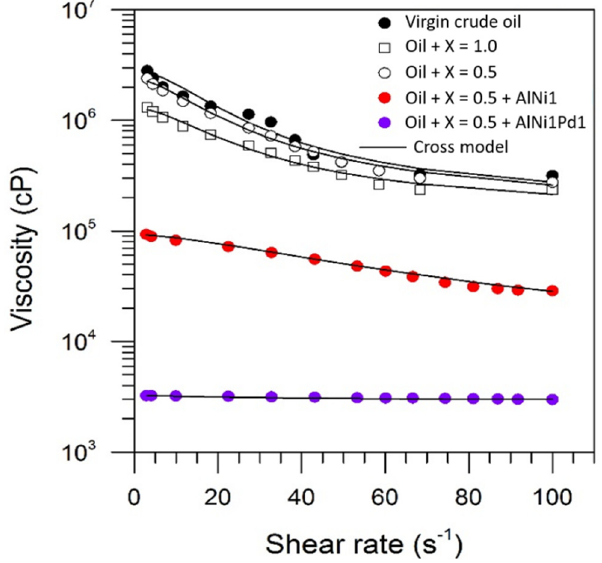
Figure 12. Recovered fluids rheological behavior at 25 °C. Virgin extra-heavy oil and oil recovered with steam injection at X = 0.5 and 1.0 and catalytic steam injection at X = 0.5 assisted by AlNi1 and AlNi1Pd1 samples. Table 4. Effect of steam injection at different qualities X = 0.5 and X 1.0 and catalytic steam injection at X = 0.5 in the presence of AlNi1 and AlNi1Pd1 in viscosity reduction degree (DVR) of an extra- heavy oil at 25 °C—the shear rate of 10 s − 1 and rheological parameters of the simulated model of Cross.